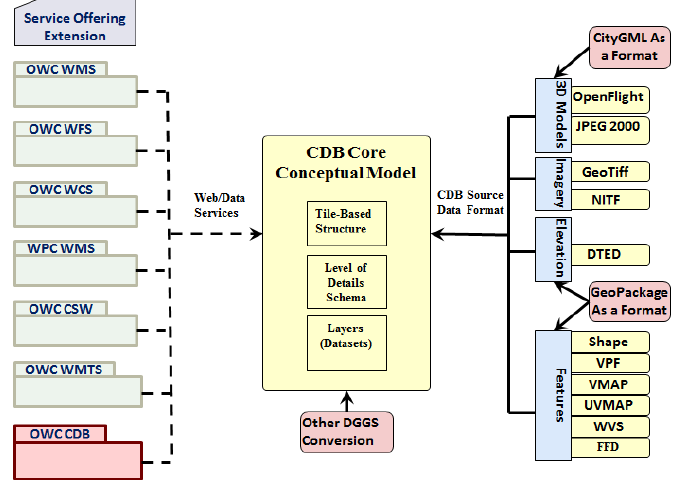
Figure 12. Conceptual model of the future OGC CDB versions.